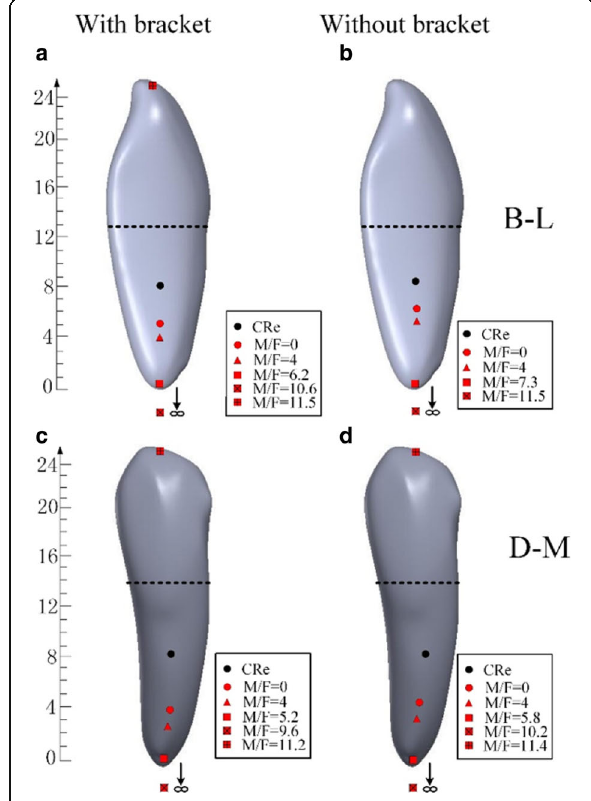
Fig. 3 Location of Cro related to the M/F ratio varied from 0 to 12 for the models. B-L represents buccal-lingual direction; D-M represents distal-mesial